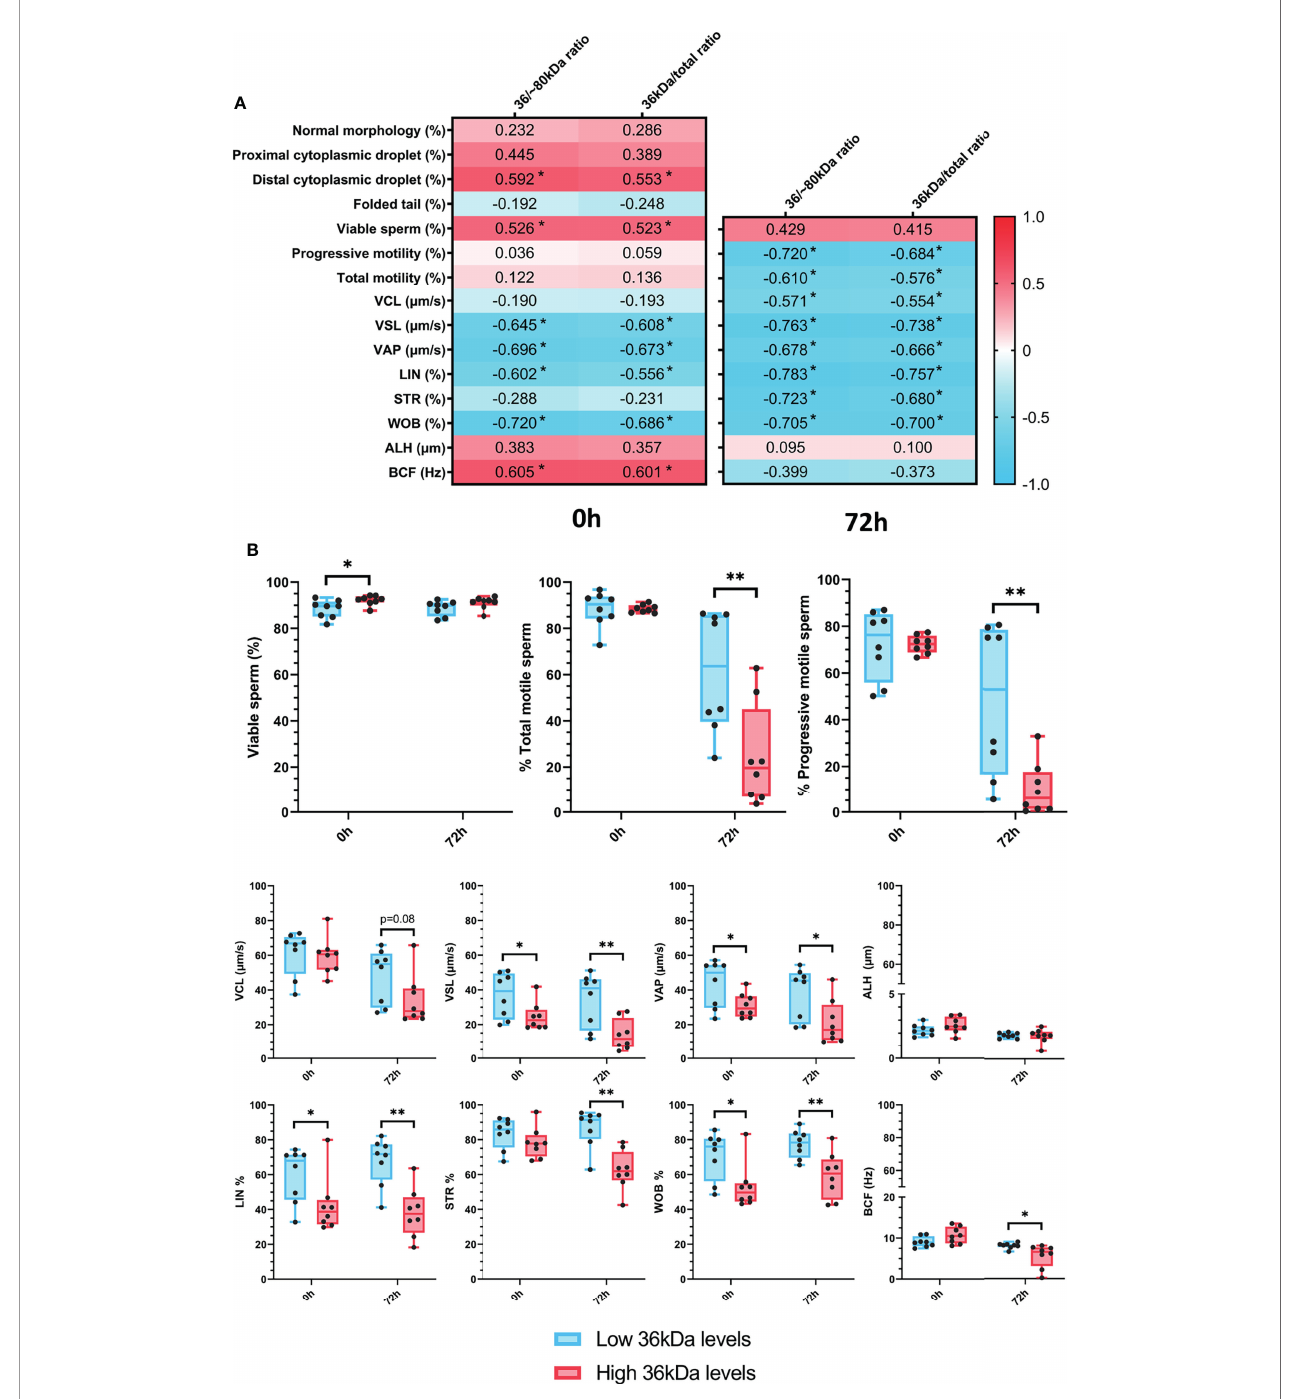
FIGURE 2 | (A) Correlation plot of sperm quality parameters (including sperm morphology, motility and viability) and 36/~80 kDa and 36 kDa/total ratios. Semen samples of 16 AI-boars (one ejaculate per boar) were evaluated immediately after semen samples arrived at the laboratory (0 h) and after storage/preservation at 17°C for 72 h. The color saturation of red to blue represents the correlation coef fi cients (R) from 1 to -1, respectively. Signi fi cant correlations ( P < 0.05) are marked with *. (B) Differences between groups with high and low levels of the 36 kDa band for viability and motility parameters evaluated at both 0 h and 72 h The box indicates the maximum and the minimum of each group, and the thicker line the median. Each dot represents one semen sample. Signi fi cant differences ( P < 0.05) are marked with * and ( P < 0.01) are marked with